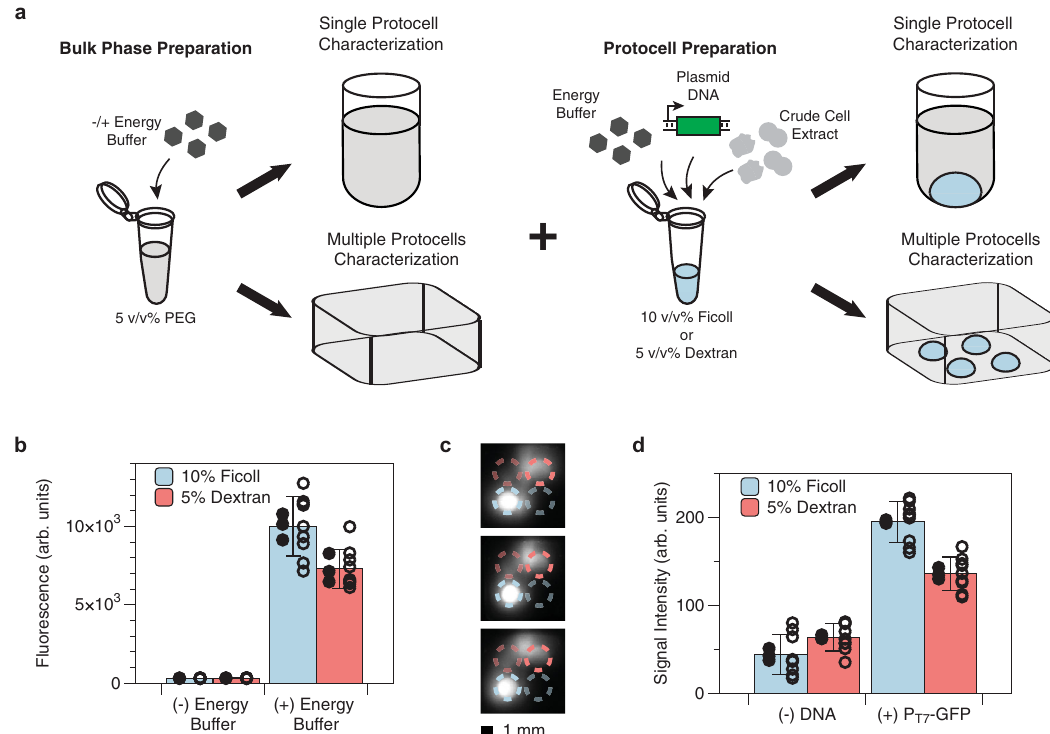
Fig. 2 Characterization of protein expression and reaction compartmentalization in membrane-less protocells. a Schematic of single-well and multi-well protocell reactions and their preparation methods. A small volume of Ficoll or dextran solution containing reagents for cell-free expression of GFP was pipetted into a bulk phase solution of PEG to form a protocell. Subsequent reactions were incubated at 37°C for 3h. b Fluorescence of Ficoll and dextran protocell reactions in single-protocell format were measured with a plate reader with 485/528nm excitation/emission wavelengths. For detectable protein expression, energy buffer must be supplemented in the bulk phase. c Fluorescence image of protocell arrays obtained by a ChemiDoc MP imager (0.5s exposure time, 530/28nm fi lter) for three biological replicates. Contents of individual protocells are indicated with colored circles: blue for Ficoll polymer-encapsulated reactions, red for dextran-encapsulated reactions. Bright colors indicate CFE reactions containing GFP plasmid for expression, and faded colors indicate negative controls with no plasmid. Scale bar is 1mm. d Quantitative assessment of fl uorescence image in c , with pixel intensity quanti fi ed by image processing software (Fiji). Data are presented as mean values±SD of 9 replicates (3 biological replicates×3 technical replicates). Solid- fi lled circles represent the mean of each biological triplicate, and hollow circles represent all data points. Details on CFE lysate used and plasmid concentrations are provided in Supplementary Table 1. Note, due to different measurement instruments being used for b and d , the arbitrary units on the y -axes are different